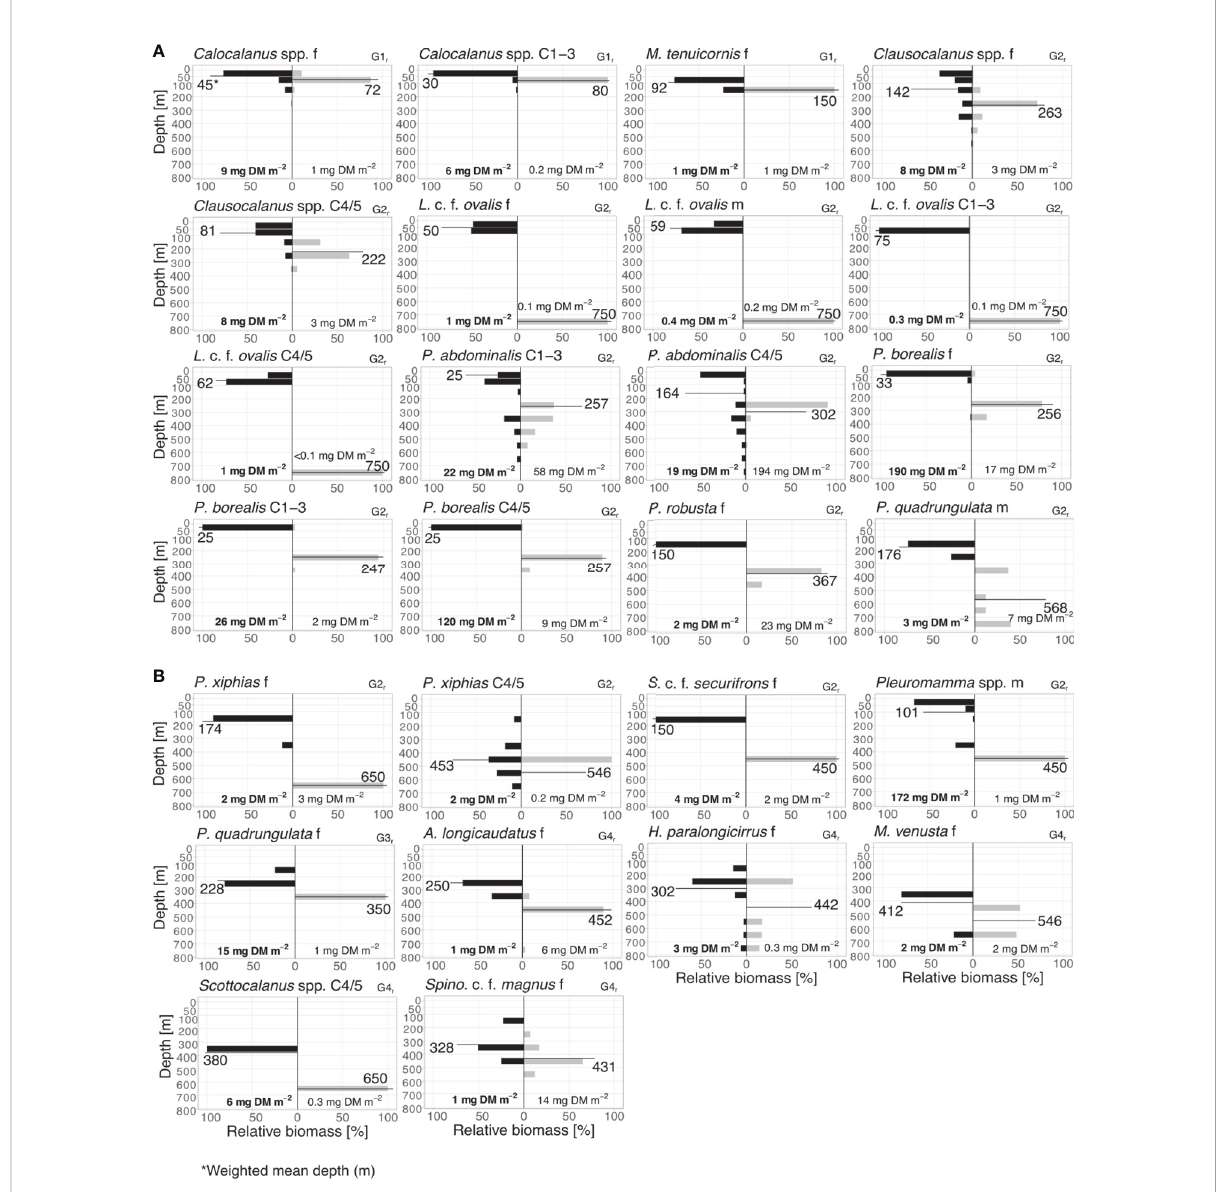
FIGURE 4 Diel vertical migrants. (A) Biomass distribution of main regular diel vertical migrants (G1 r – 2 r ) and (B) biomass distribution of main regular diel vertical migrants (G2 r – 4 r ). Absolute total biomass values (mg DM m -2 ) are given for day (grey bars) and night (black bars) for each taxon. Weighted mean depths (m) for day and night for each group are